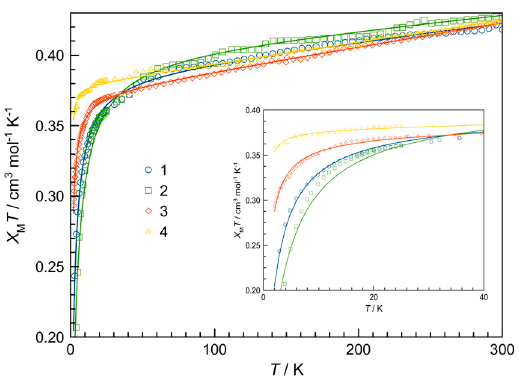
Figure 5. Thermal dependence of the χ M T product for 1 – 4 . The inset shows a detail of the low-tem- perature domain.